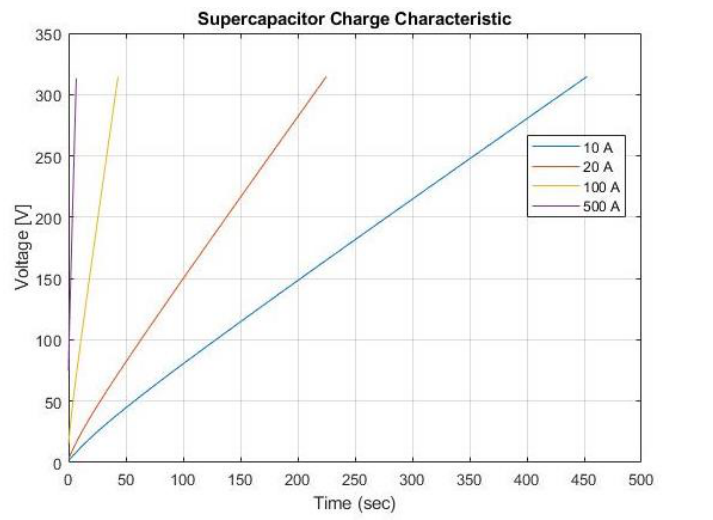
Figure 4. Supercapacitor charge curve [39]. Table 4. Features of the supercapacitor used in the